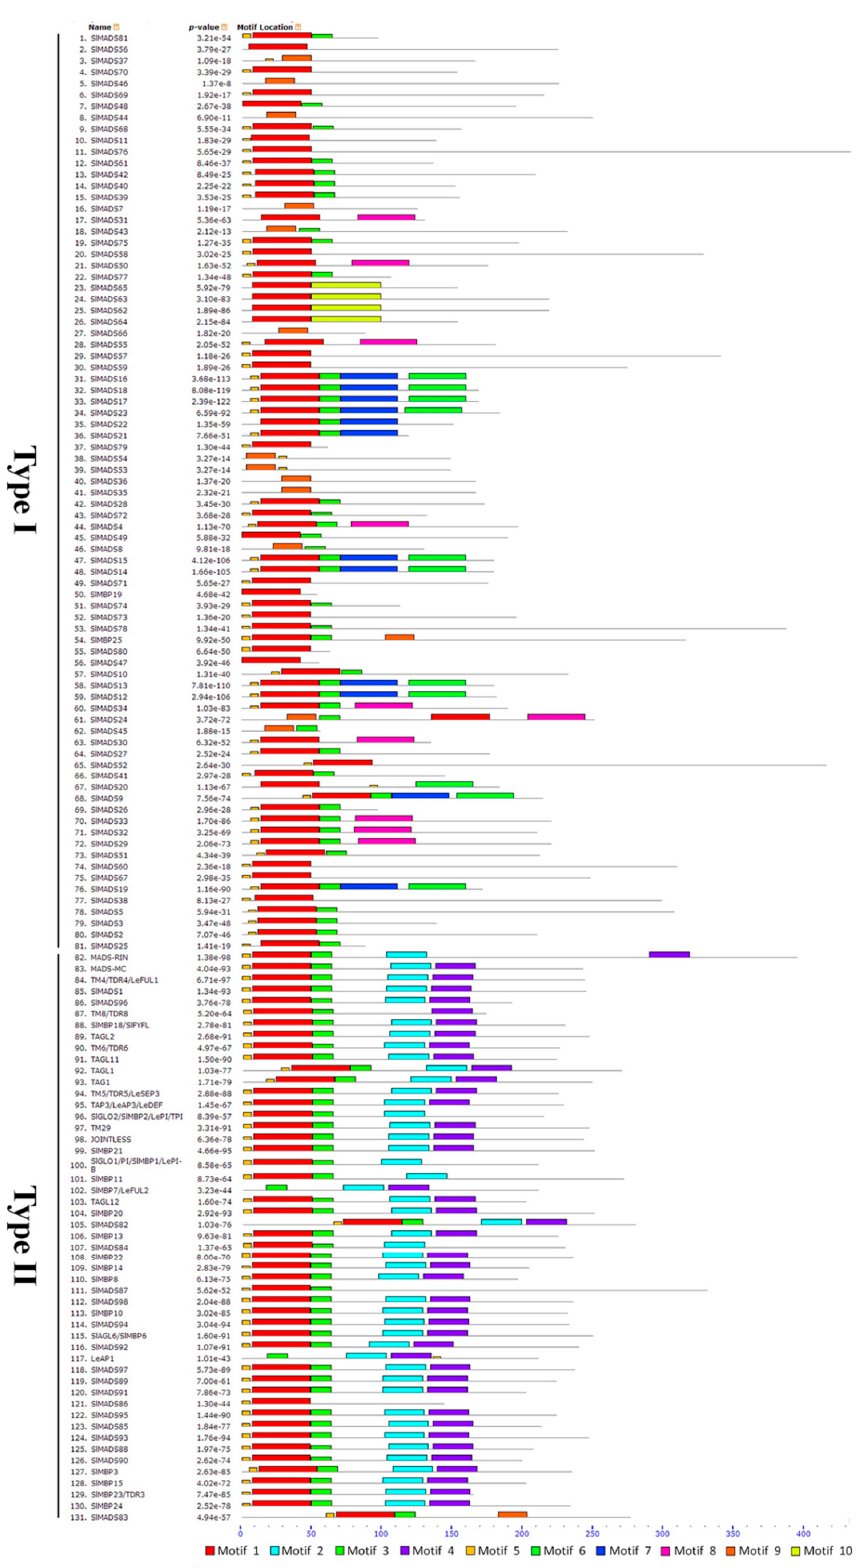
Figure 2. Conserved motif analyses of MADS-box genes in tomato. All the conserved motifs were identified by the Multiple EM for Motif Elicitation (MEME) database using the complete amino acid sequences of tomato MADS-box genes. Ten conserved different motifs were indicated by different colors. The details of motifs refer to the Supplementary Figure S2.